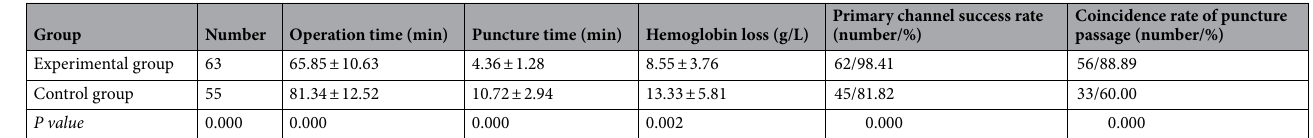
Table 2. Comparison of operation between the two groups.